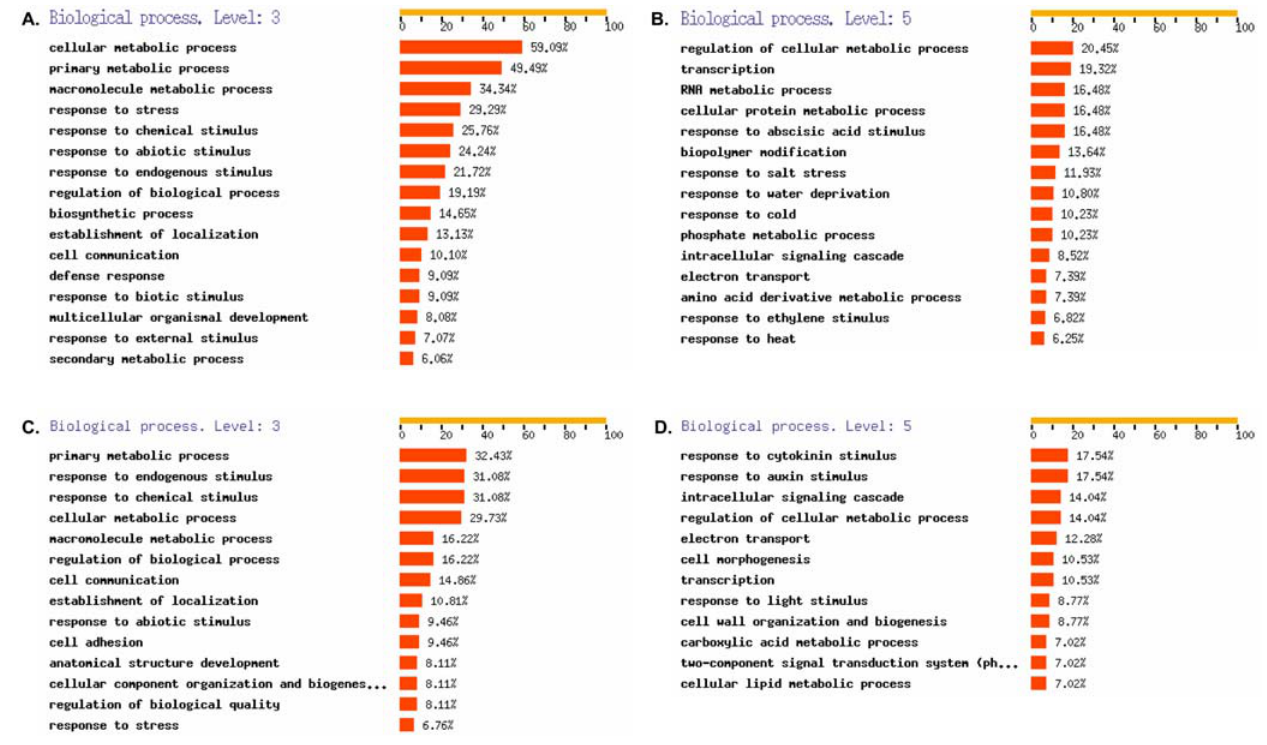
Figure 3. GO categorization of Arabidopsis genes differentially expressed after inoculation with R.solanacearum using FatiGo [ 42 ] . A. and B. 198 genes with annotations out of 352 disease-associated total up-regulated genes categorized at GO biological processes level 3 and 5, respectively. C. and D. 74 genes with annotations out of 118 total disease-associated down-regulated genes, categorized at biological processes level 3 and level 5. Percentages relate to the total number of genes with an ontology at each level. Only categories corresponding to more than 6% of total number of genes are shown.